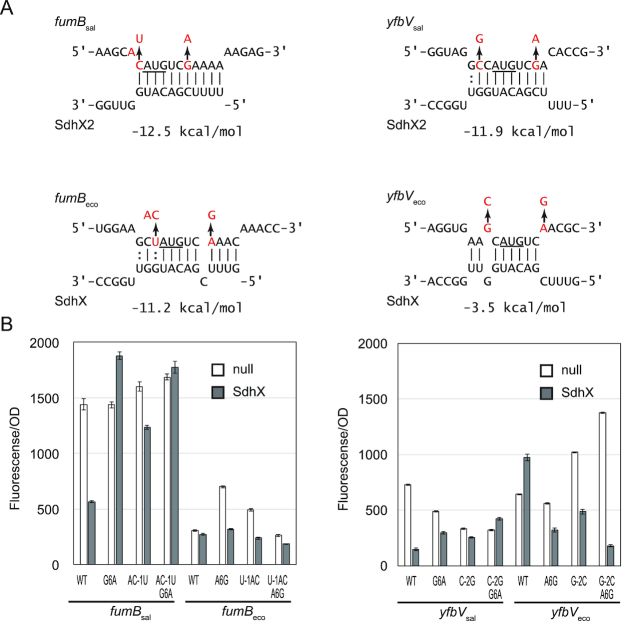

E. coli fumB and yfbV are not regulated by SdhX due to mutations around their start codons. (A) Difference in fumB-SdhX and yfbV-SdhX interactions between Salmonella and E. coli. The start codon is underlined. Exchanged nucleotides were indicated by red letters. Changes in free energy (ΔG°) upon basepairing are indicated below the interactions. (B) Salmonella ΔsdhX strain was transformed by combinations of mutant pXG plasmids along with pJV300 control vector (null) or SdhX expression plasmid (SdhX). GFP expression was quantified and normalized by OD600. Error bars indicate standard deviations (n = 3).